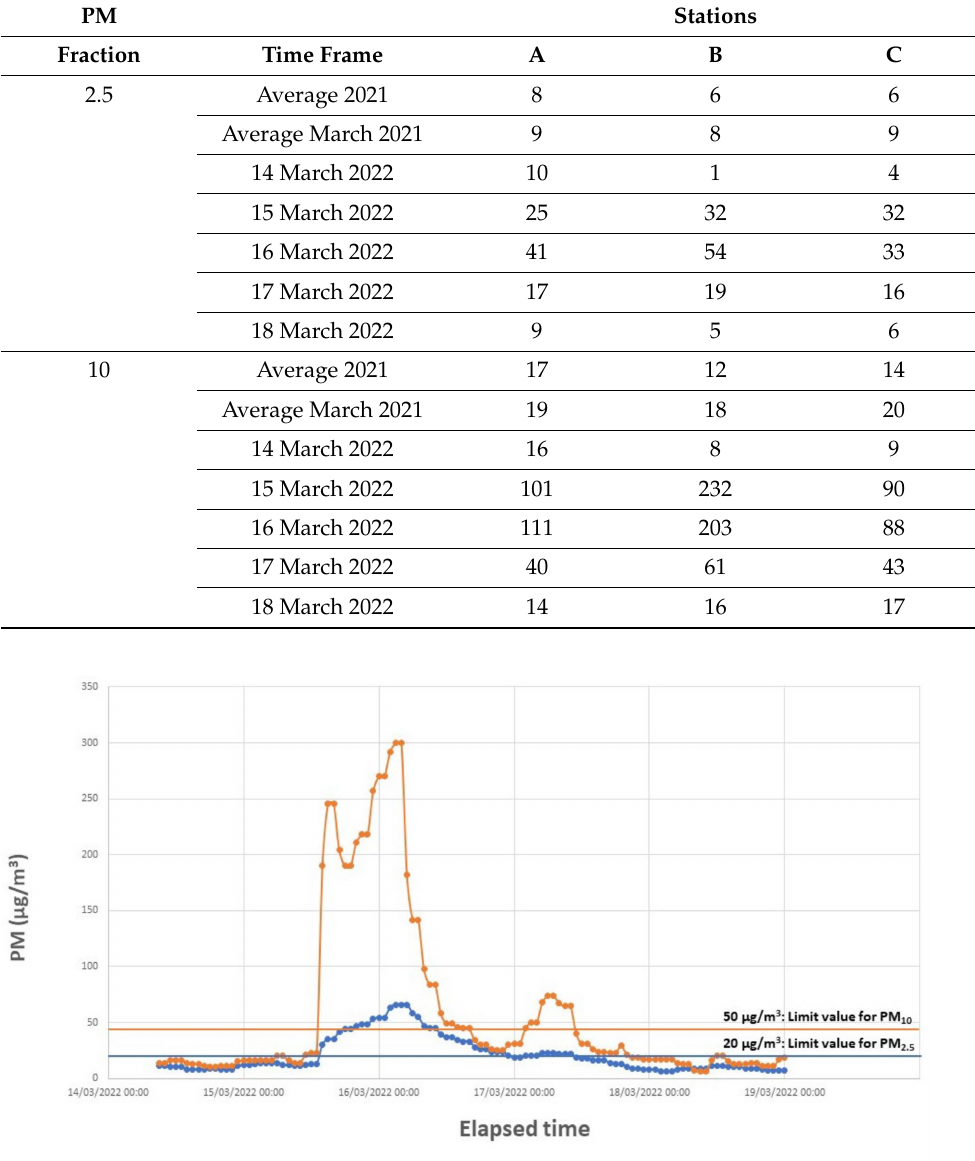
Table 1. PM 2.5 and PM 10 daily and monthly mean observed concentrations ( µ g/m 3 ) in stations A, B, and C. Source: https://qualar.apambiente.pt (accessed on 23 June 2022).